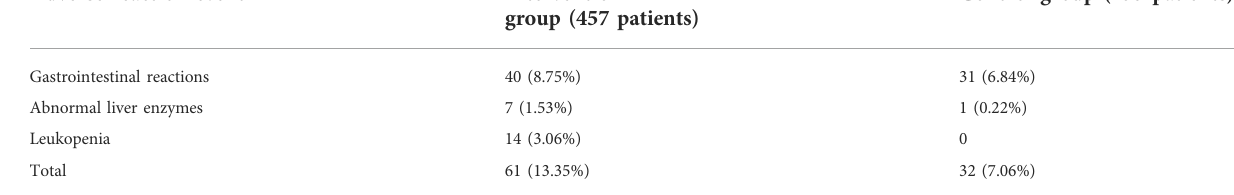
TABLE 5 Statistic of adverse reaction events.